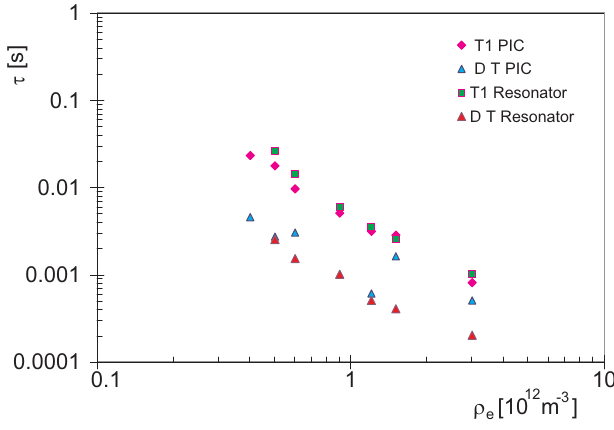
FIG. 20. (Color) Vertical emittance as a function of time for the FIG. 19. (Color) Rise times of the emittance growth as a func- SPS, comparing different values of vertical chromaticity Q 0 at tion of the electron-cloud density obtained by the HEADTAIL code (cid:2) (cid:2) 10 12 m (cid:4) 3 without space with the electron-cloud PIC simulation and for an equivalent (cid:2) 9 and Q (cid:2) 3 ); T1 denotes the time broadband resonator ( H enh during which the emittance increases from 7 : 82 (cid:6) 10 (cid:4) 9 m (ini- tial value) to 8 (cid:6) 10 (cid:4) 9 m , (cid:1) T the interval in which the emittance rises from 8 (cid:6) 10 (cid:4) 9 m to 8 : 2 (cid:6) 10 (cid:4) 9 m ( (cid:5) 2 : 5% ).